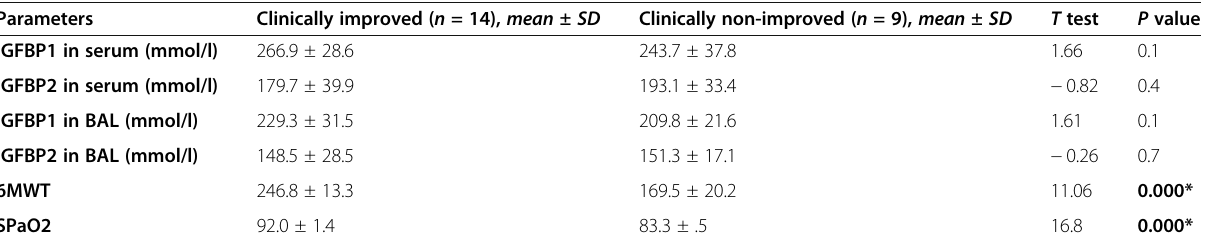
Table 2 Comparison between the clinically improved and clinically non-improved groups as regards IGFBP1 and IGFBP2 in serum and BAL, 6MWT, and SPaO2